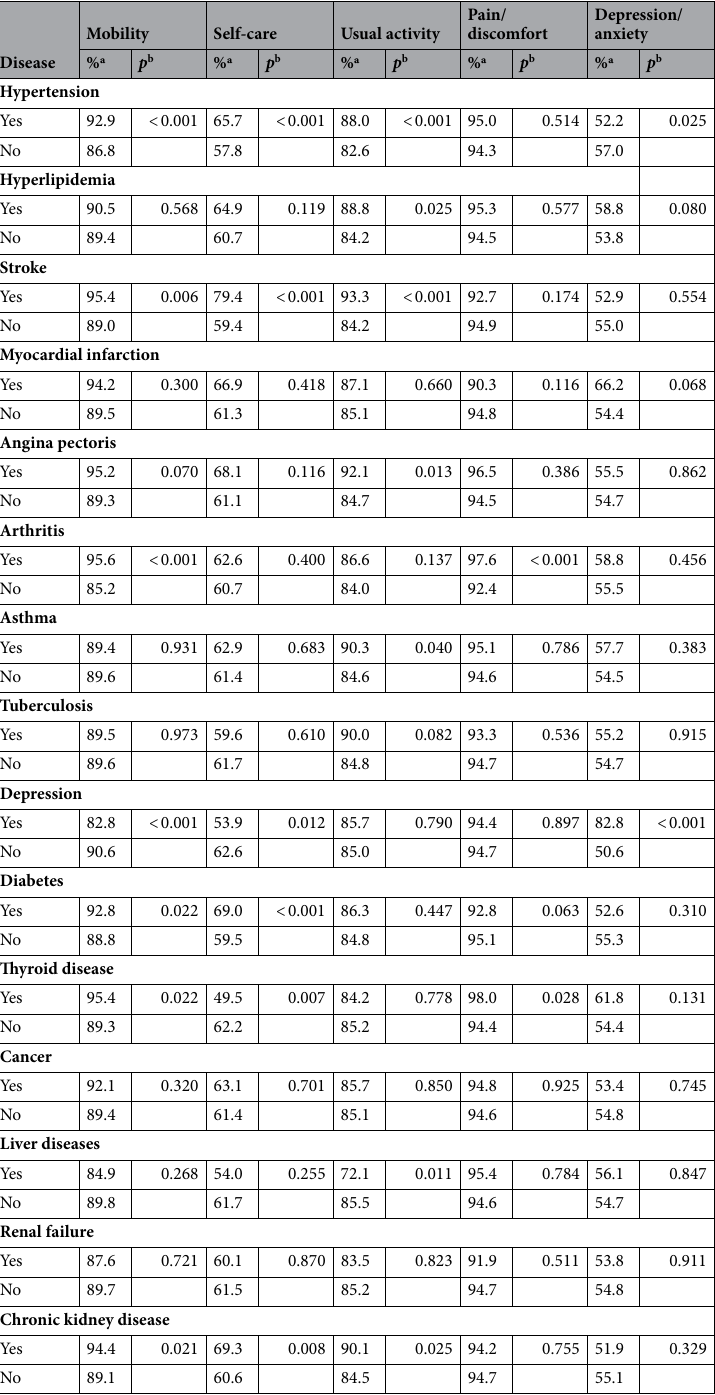
Table 2. Moderate or extreme problems reported in the five HRQoL dimensions by disease status in the low- HRQoL population. a Proportion of reporting problems (either moderate or severe) in each HRQoL dimension by disease status, weighted values. b p -values were obtained from the Chi-square test to compare the proportion of reporting problem between those with and without having a